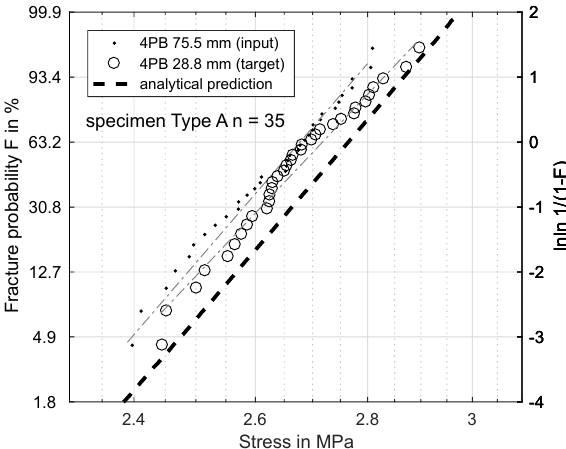
Figure 8. Specimen Type A: prediction of fracture probability from 4PB (75.5 mm) to 4PB (28.8